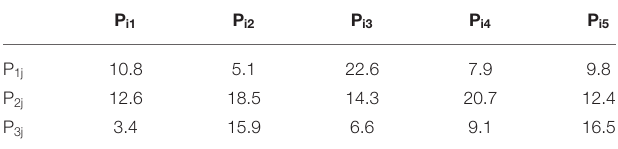
TABLE 1 | The porosity of 15 indentation points (%).